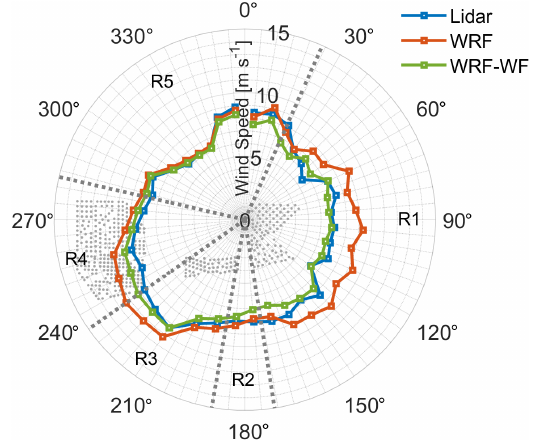
Figure 14. Wind speed polar plot of the lidar (blue) and WRF model without (red) and with wind farm influences (WRF-WF, green) at 120m. Wind turbines are indicated as gray points, and the sectors are indicated as dashed gray